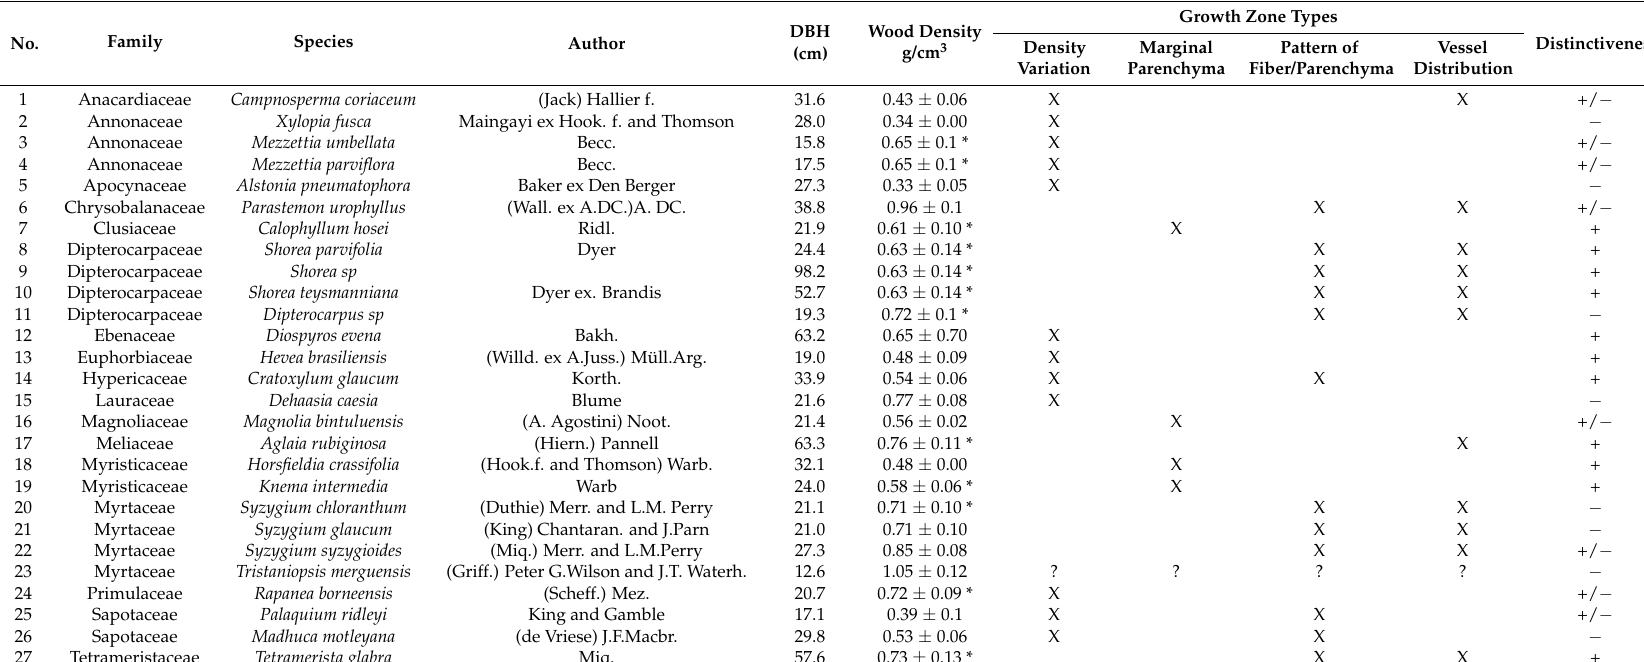
Table 1. Overview of the samples and some anatomical features of the wood including family, species name, author, diameter at breast height (DBH), wood density, growth zone types and distinctiveness of growth zone boundaries. Distinctiveness is a subjectively recorded parameter based on visual inspection (examples in Figure 4, see also text, and [30]). The classification into four growth zone types follows [5]. Wood density is derived from the ICRAF wood density data